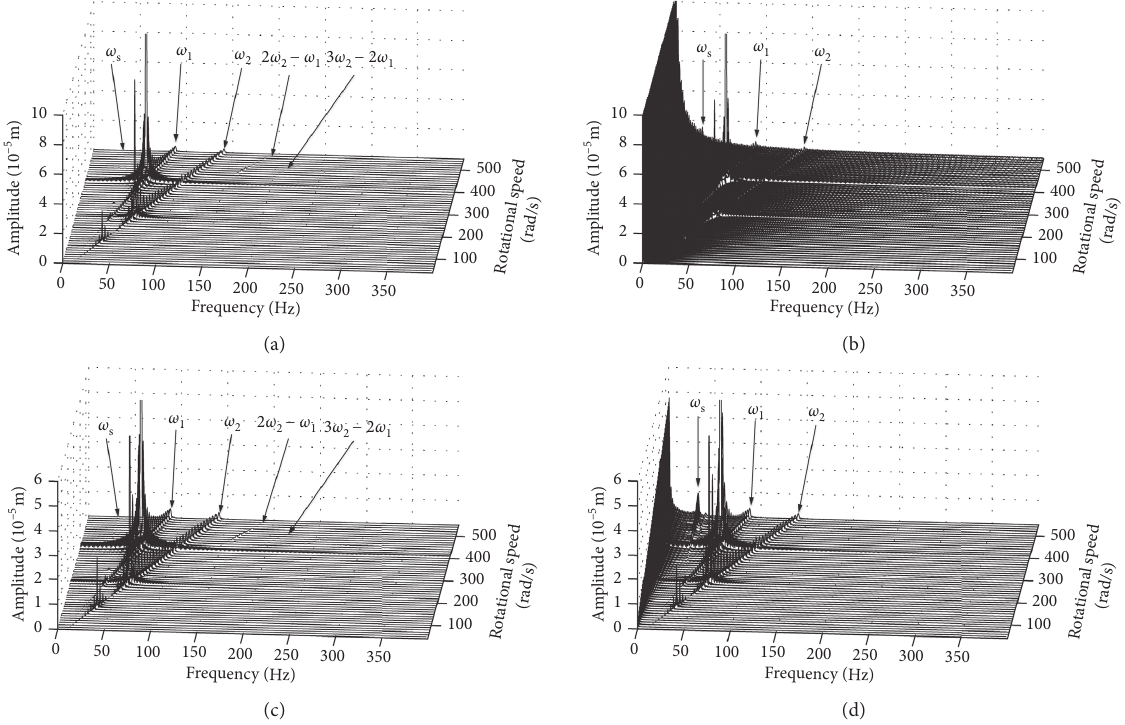
Figure 14: Waterfall spectra plots for the vibration of disk 4. (a) Horizontal response, straight flight. (b) Horizontal response, hovering. (c) Vertical response, straight flight. (d) Vertical response, hovering.